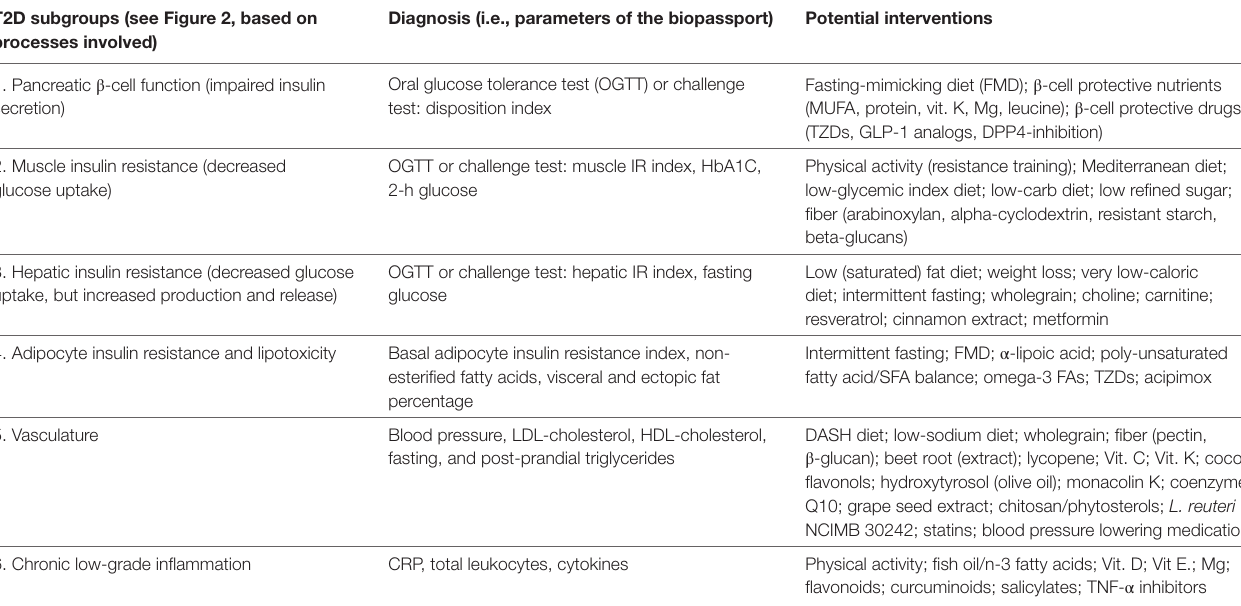
TABLe 1 | Type 2 diabetes subgroup (process) dependent diagnosis–intervention strategies. T2D subgroups (see Figure 2, based on Diagnosis (i.e., parameters of the biopassport) Potential processes involved)